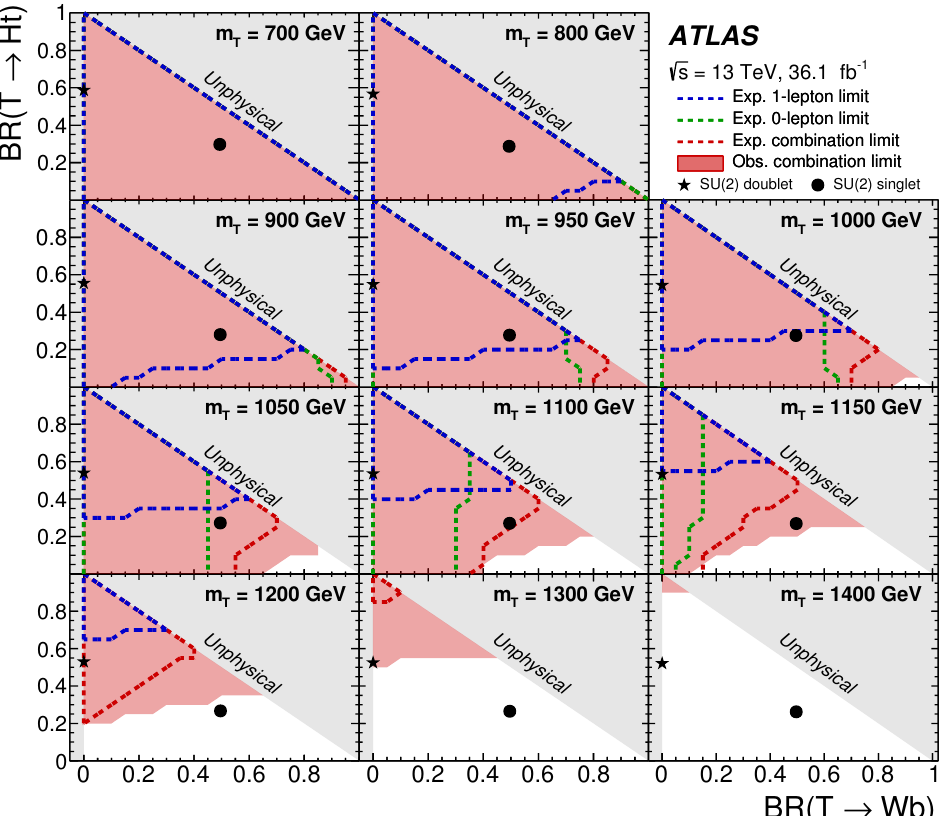
Figure 18. Observed (red (cid:12)lled area) and expected (red dashed line) 95% CL exclusion in the plane of ( T Wb ) versus ( T Ht ), for di(cid:11)erent values of the vector-like T quark mass for B ! B ! the combination of the 1-lepton and 0-lepton searches. In the (cid:12)gure, the branching ratio is denoted \BR". The background estimate used in the computation of the limits is the result obtained from the background-only (cid:12)t to data. Also shown are the expected exclusions by the individual searches, which can be compared to that obtained through their combination. The grey (light shaded) area corresponds to the unphysical region where the sum of branching ratios exceeds unity, or is smaller than zero. The default branching ratio values from the Protos event generator for the weak-isospin singlet and doublet cases are shown as plain circle and star symbols,